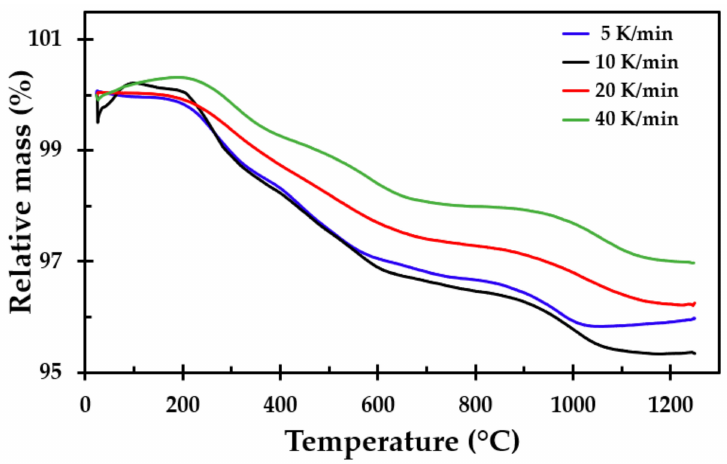
Figure 10. Thermogravimetric analysis of the thermal insulation in a nitrogen atmosphere.